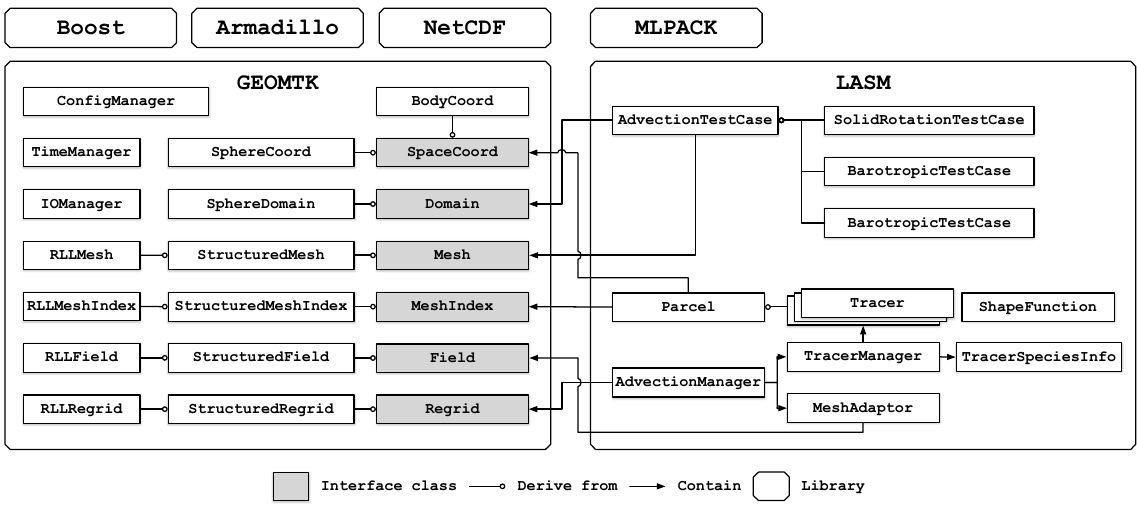
Figure 6. The overall programming units of LASM and their relationship. Four external libraries (Boost, Armadillo, NetCDF, and MLPACK) are used.